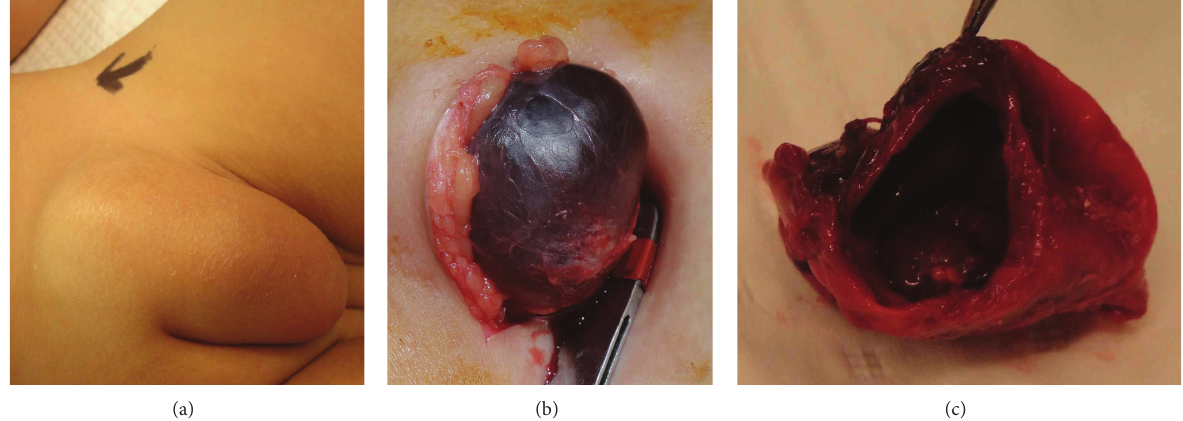
Figure 1: Operative images of left inguinolabial region showing (a) swelling extending down to ipsilateral labium majus, (b) tense encysted cystic swelling containing dark-brown fluid, and (c) excised and opened